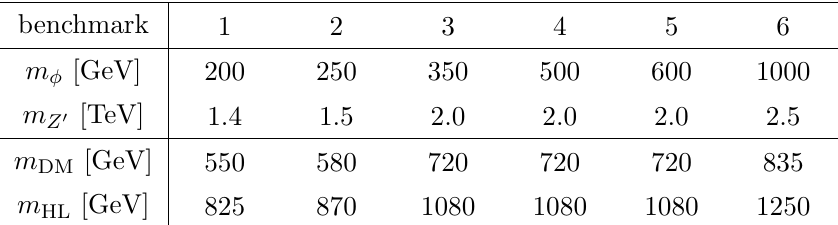
Table 3 . Benchmark values of the scalar and Z 0 masses, along with the DM and exotic lepton masses for the benchmark points D1 |